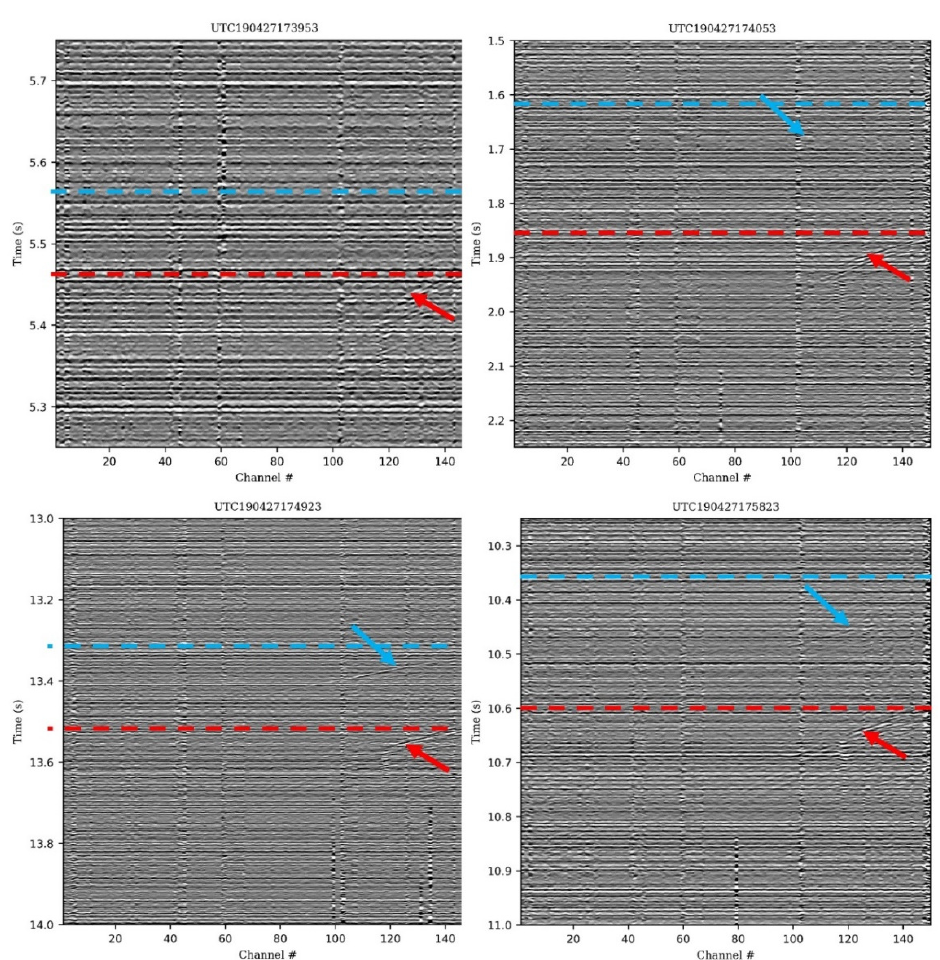
Figure 13. Sample of the low magnitude events detected by the CNN but were not in the events catalog. The red lines represent the S-wave arrival times while the cyan shows the estimated P-wave arrivals. Similarly, the cyan and red arrows show the P- and S-waves respectively.